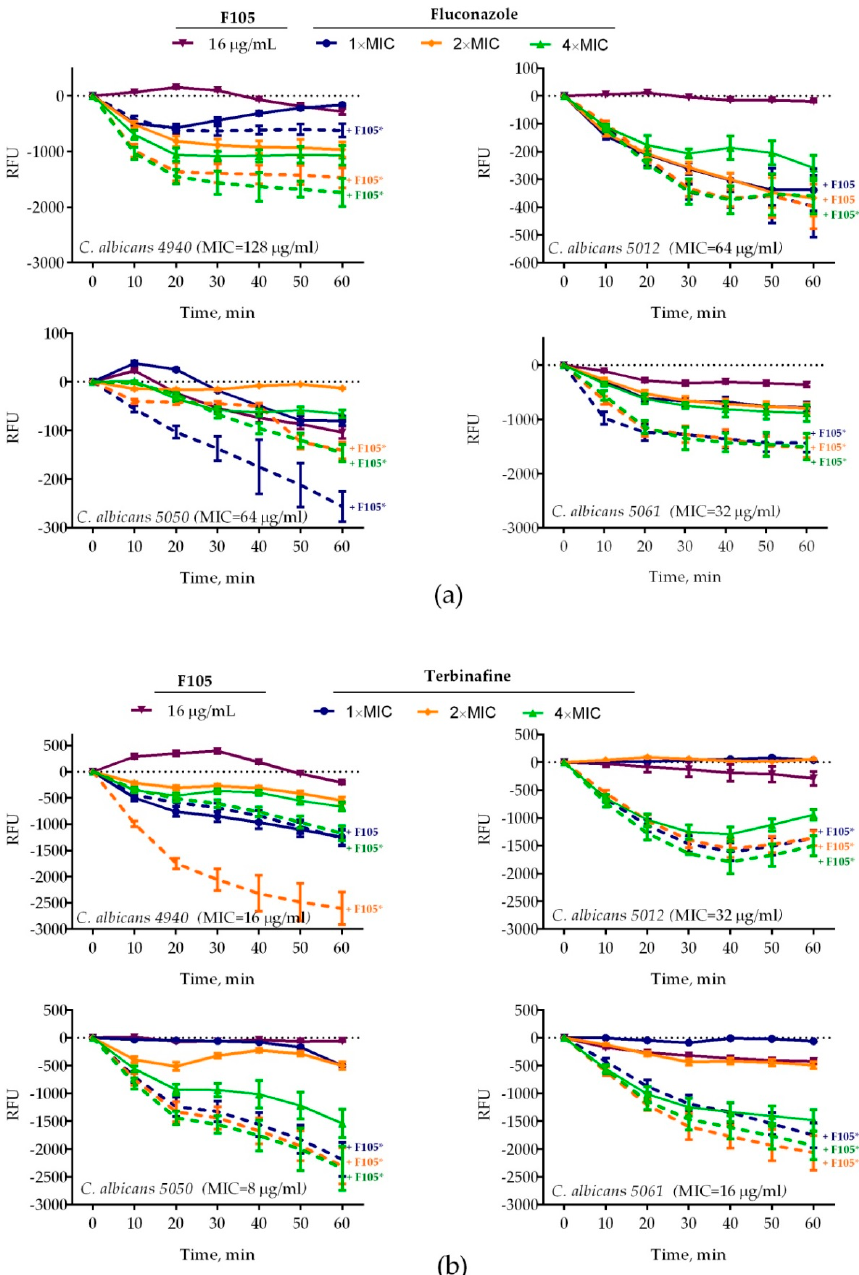
Figure 3. Relative membrane potentials of C. albicans isolates after treatment with F105 16 μ g/mL and/or ( a ) fluconazole or ( b ) terbinafine (1×, 2×, or 4× of corresponding MIC, see Table 1 for values) either alone or in combination. C. albicans cells in the late exponential growth phase were harvested, washed with phosphate-buffered saline (PBS), and resuspended in PBS supplemented with 10 μ M DioC 2 (3). After 30 min preincubation, compounds were added as indicated and the fluorescence was measured for 60 min with 10 minute intervals. Lines represent the median values with IQRs from five independent measurements. In cases marked with *, the measured RFUs after 60 min of exposure were significantly lower in the presence of F105 compared to similar treatments in the absence of F105 according to the Kruskal–Wallis statistical test at p < 0.05. Corresponding MICs of antifungals are given in parentheses after the strain names.